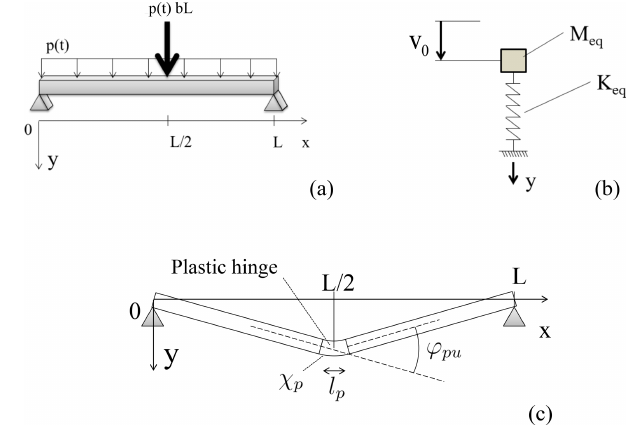
Figure 4. Simply supported beam (a) , mass-spring system (b) , and failure mode of the RC wall (c)